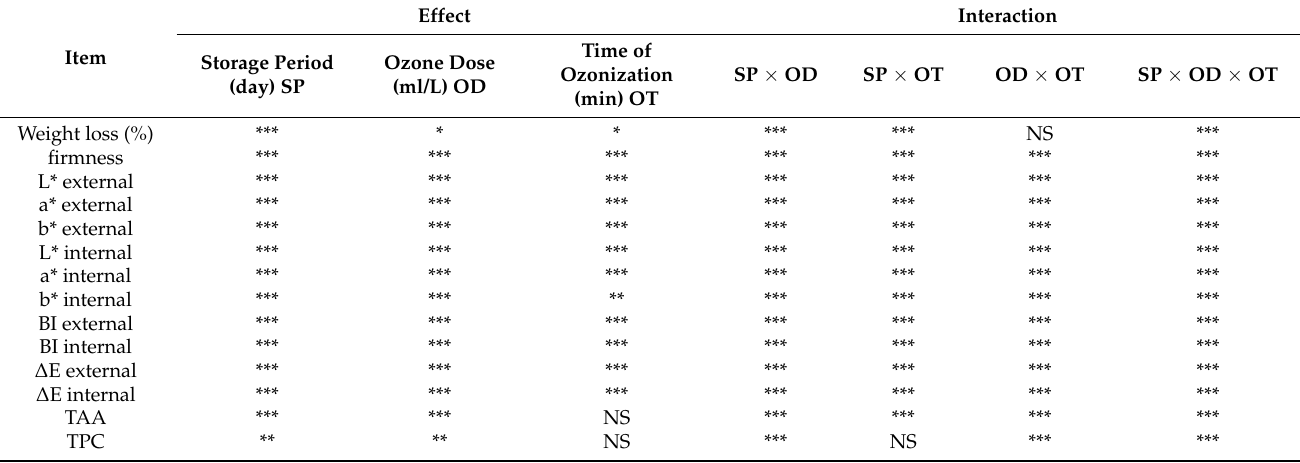
Table 1. Test probabilities for physicochemical characteristics, in general, depending on storage period, ozone dose, and time of ozonization—multi-aspect variance analysis including